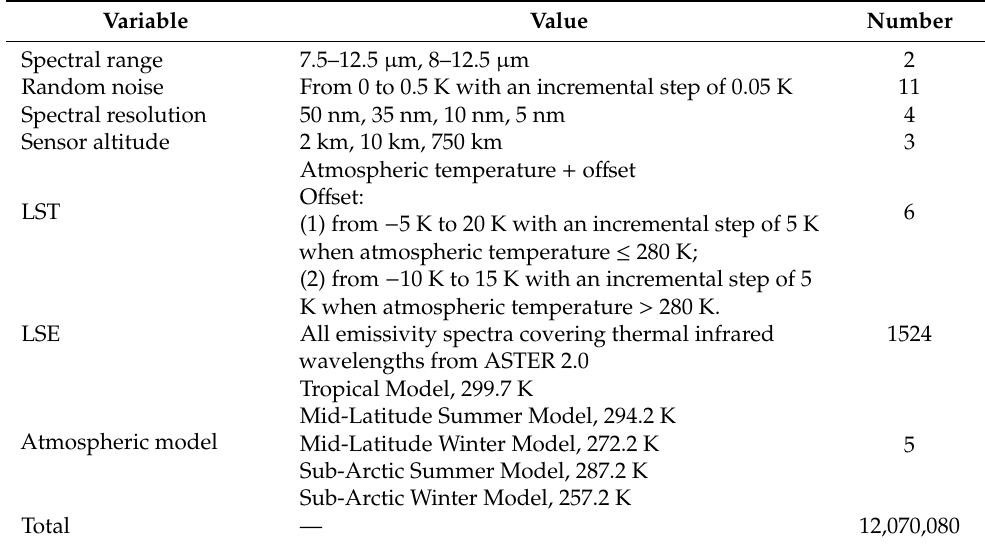
Table 1. Primary variables setup of simulation